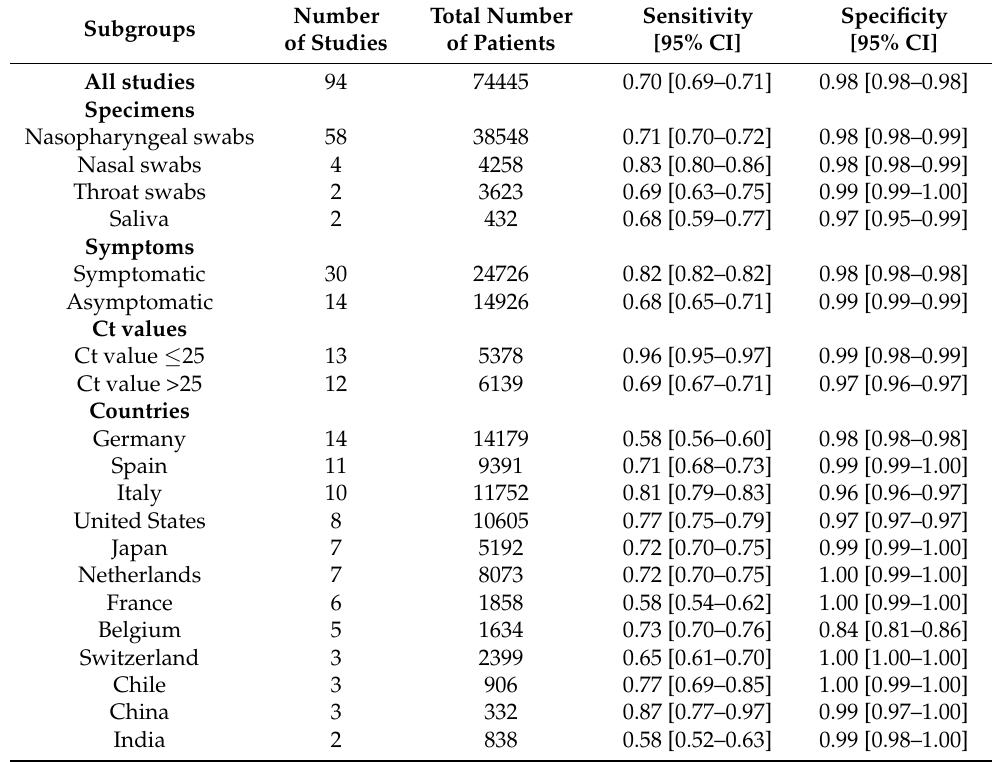
Figure 3. The forest plot of sensitivity and specificity of rapid antigen tests for SARS-CoV-2. Table 3. Summary of subgroups analysis of the sensitivity and specificity of rapid antigen tests for